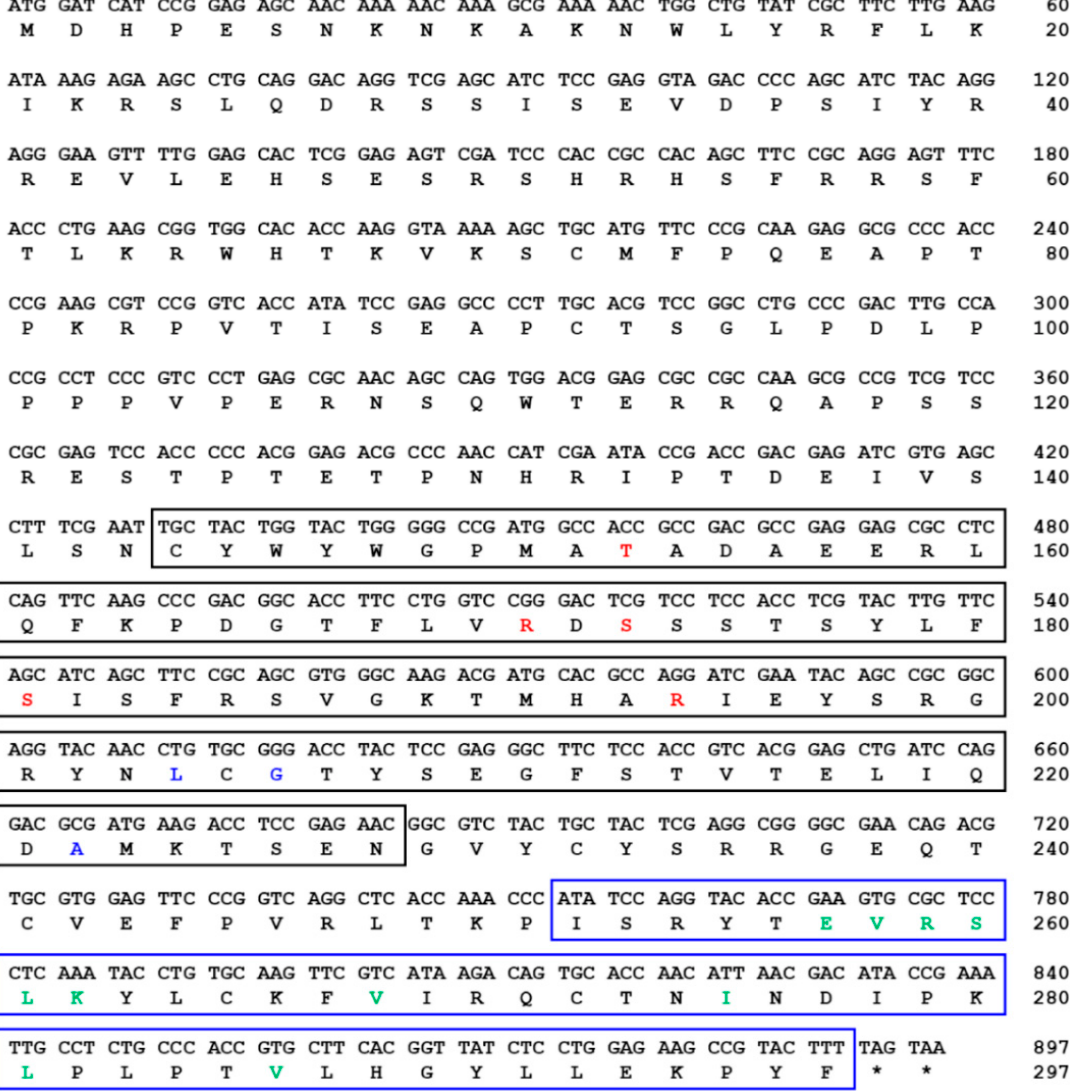
and blue boxes, respectively. The polypeptide binding sites, including the phosphotyrosine binding pocket, hydrophobic binding pocket, and putative elongin B/C interaction residues, are shown in red, blue, and green text, respectively.